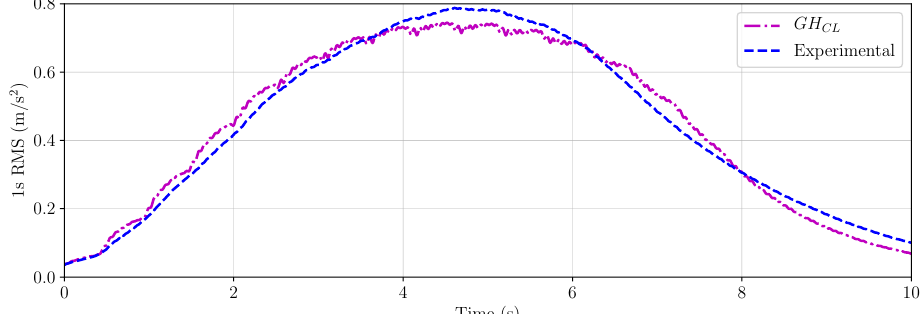
Figure 12. Comparison of 1s RMS acceleration employing the identified HSI